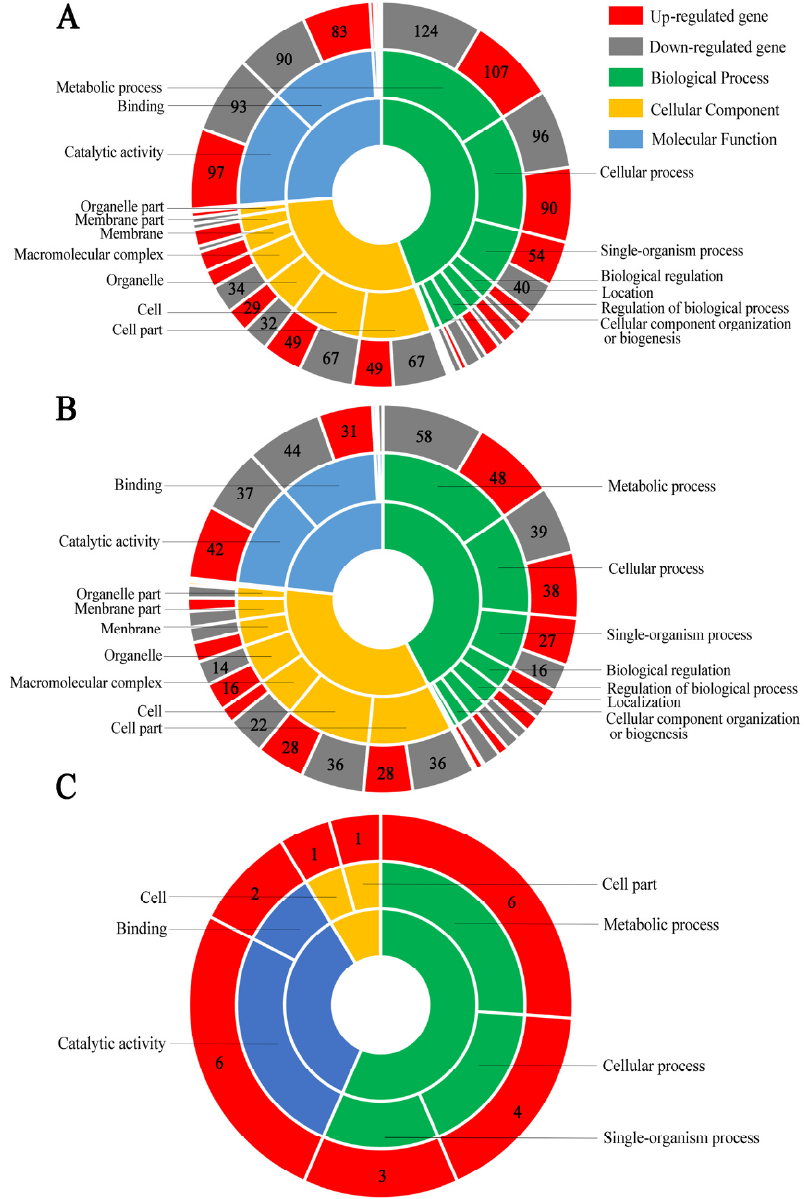
Figure 4. GO categor y of DEGs. ( A ) DEGs in NcCK vs. NcT1. ( B ) DEGs in NcCK vs. NcT2; ( C ) DEGs in NcT1 vs. NcT2. in NcT1 vs.